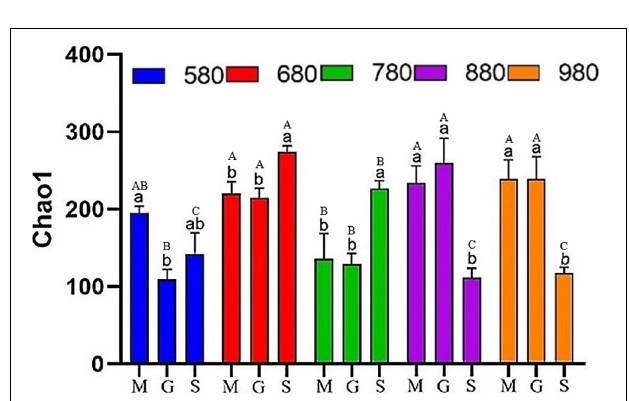
FIGURE 2 | The α diversity indices of phyllosphere bacteria among different elevations and growth stages. Comparison of α diversity of rice phyllosphere bacteria at different growth stages at the same elevation, M: seedling stage, G: heading stage, S: mature stage. Capital letters indicate significant differences between different growth stages at the same growth stage. Lowercase letters indicate significant differences at different elevations at the same